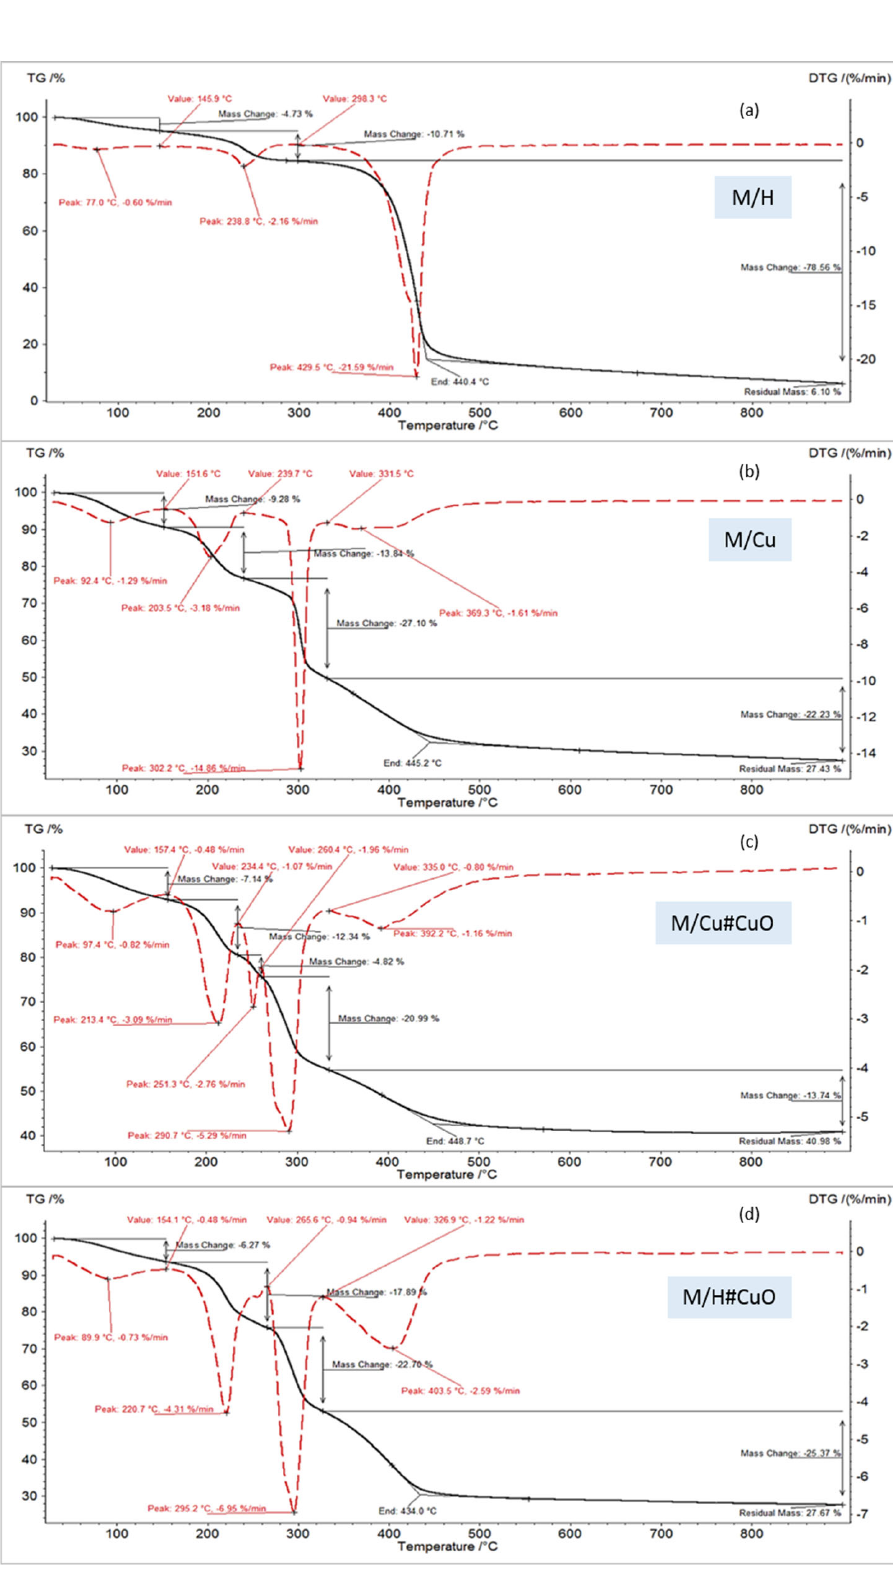
Figure 6. TG/DTG curves in N 2 of ( a ) M/H, ( b ) M/Cu, ( c ) M/Cu#CuO, and ( d ) M/H#CuO.